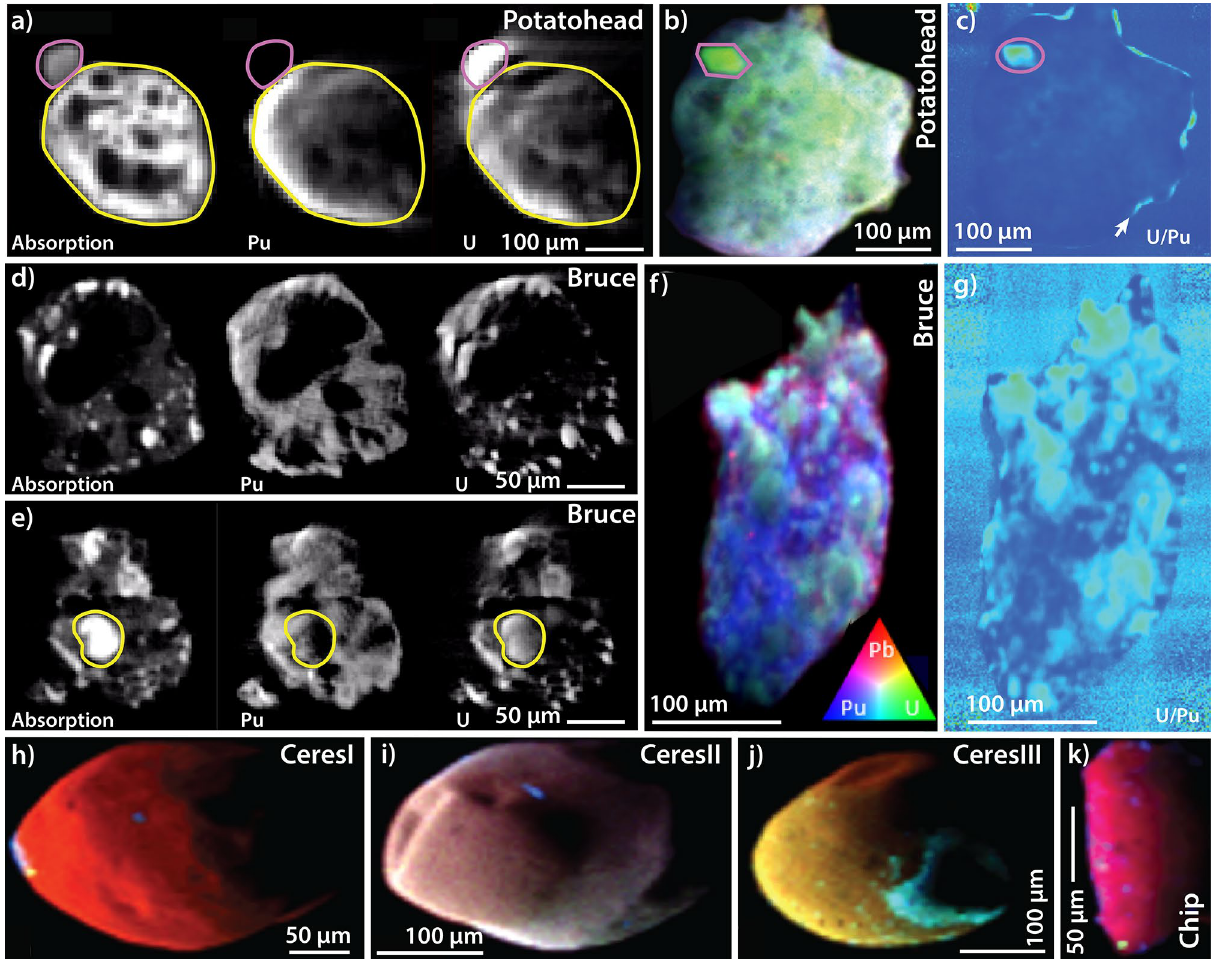
Figure 1. X-ray µ-tomography ( a , d , e ) and µSXRF imaging ( b – c , f – i ) of hot particles from Maralinga. In ( a ) ( Potatohead ) the low-X-ray cross-section areas within the particles (black) correspond to pores, whereas in ( d ) and ( e ) ( Bruce ) they correspond to Al-oxide rich domains. Potatohead displays a U-rich grain (purple circle in a , b , c ) attached on the outside of the particle; in ( e ), a U-rich, Pu-poor inclusion is highlighted in